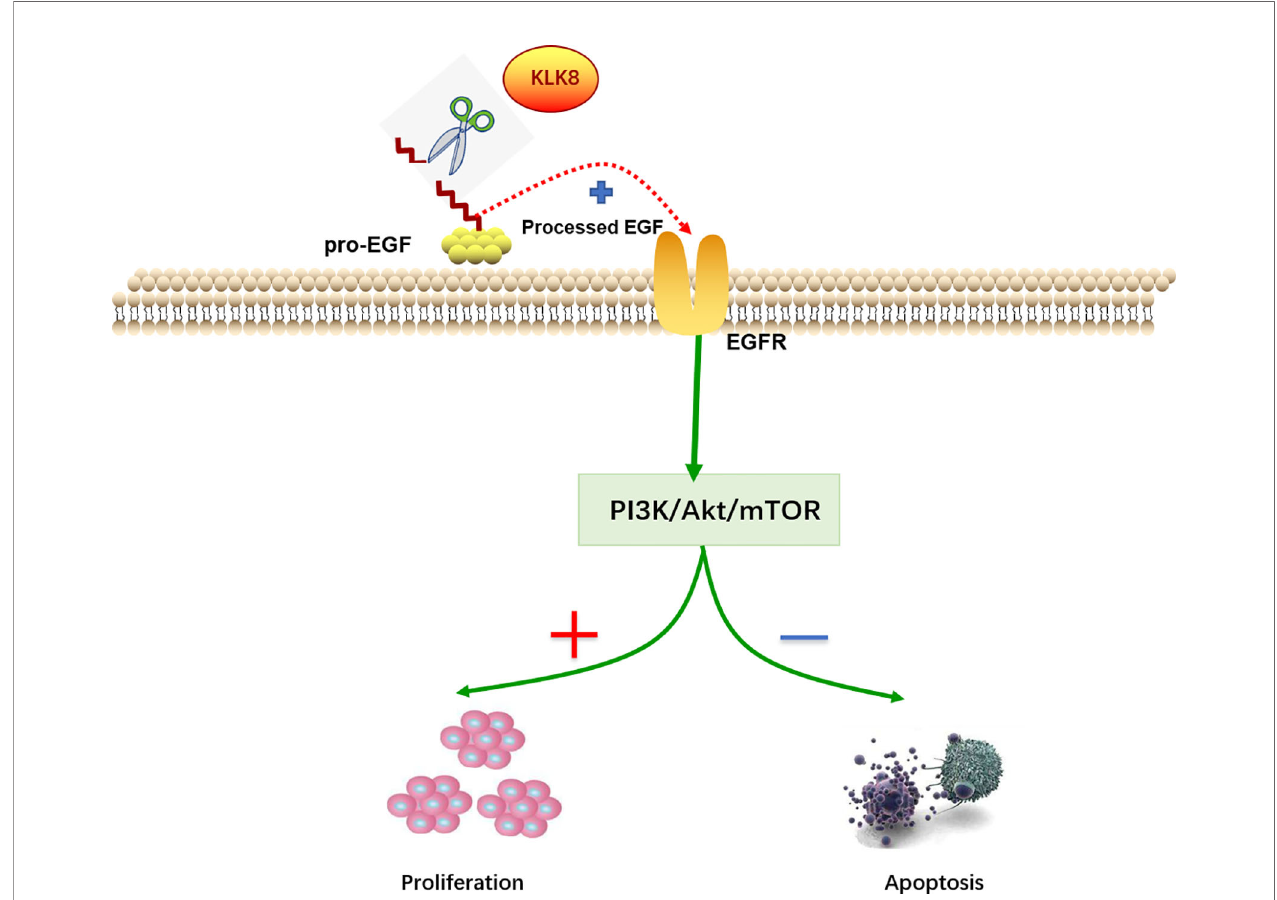
FIGURE 10 | Molecular mechanisms of KLK8-induced pro-proliferation and anti-apoptotic effects in pancreatic cancer cells. KLK8-mediated release of mature EGF contributes to the activation of PI3K-Akt-mTOR signaling pathway, thereby promoting the proliferation and inhibiting the apoptosis of pancreatic cancer